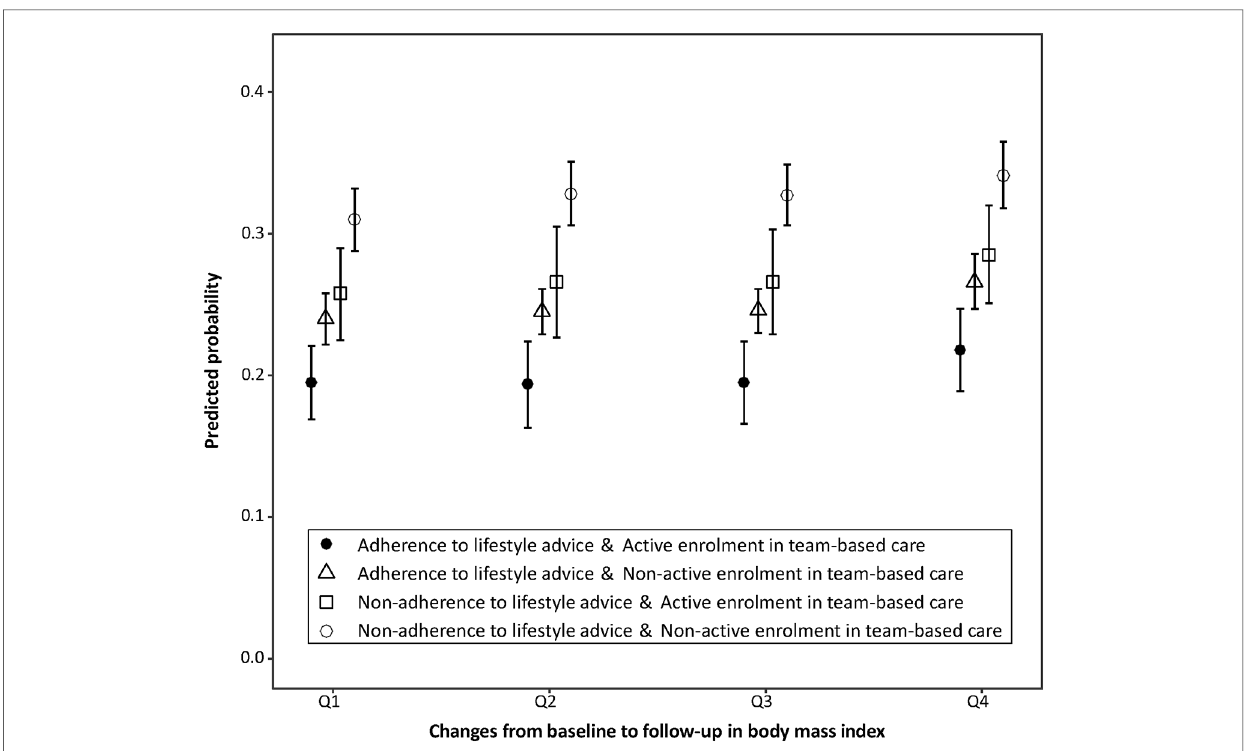
FIGURE 2 Predicted probability of no improvement in BP and FPG at follow-up. Note: Changes from baseline to follow-up in body mass index were divided into quartiles from greatest weight gain (Quartile 4; median change: 1.46 kg/m 2 ) to least gain or loss (Quartile 1; median change: − 1.00 kg/m 2